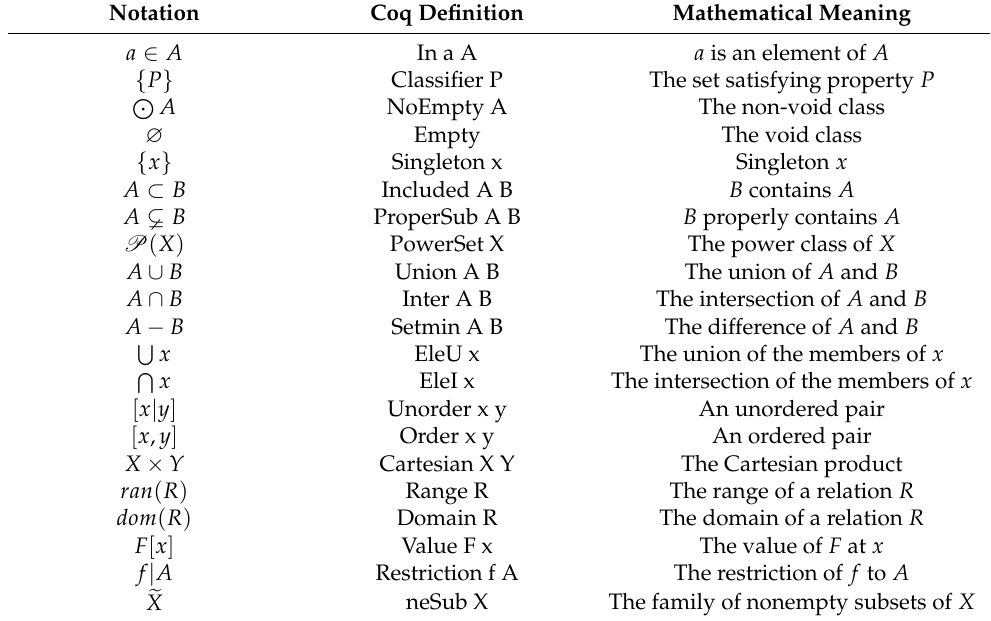
Table 1. The notations in our formal